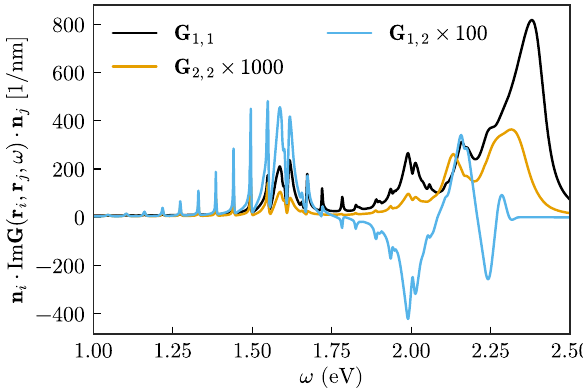
Figure 2: Green ’ s function factor n i ⋅ Im G ( r i , r j , ω ) ⋅ n j connecting the two emitters in the geometry of